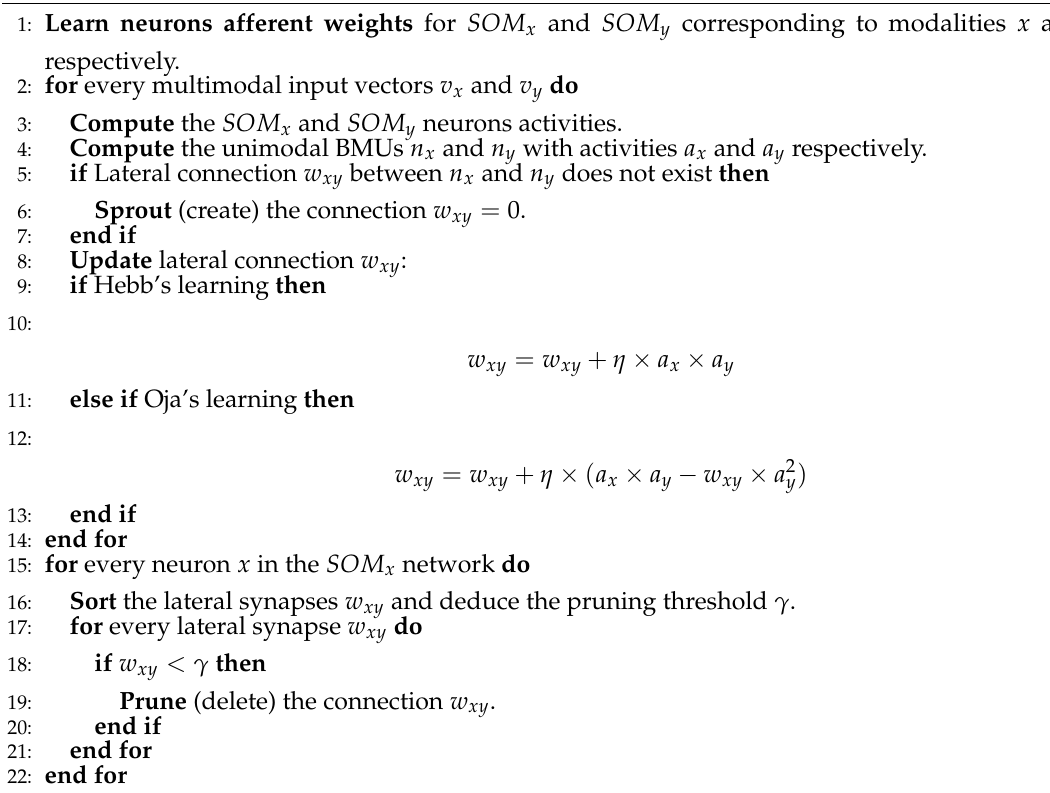
Algorithm 2 ReSOM multimodal association